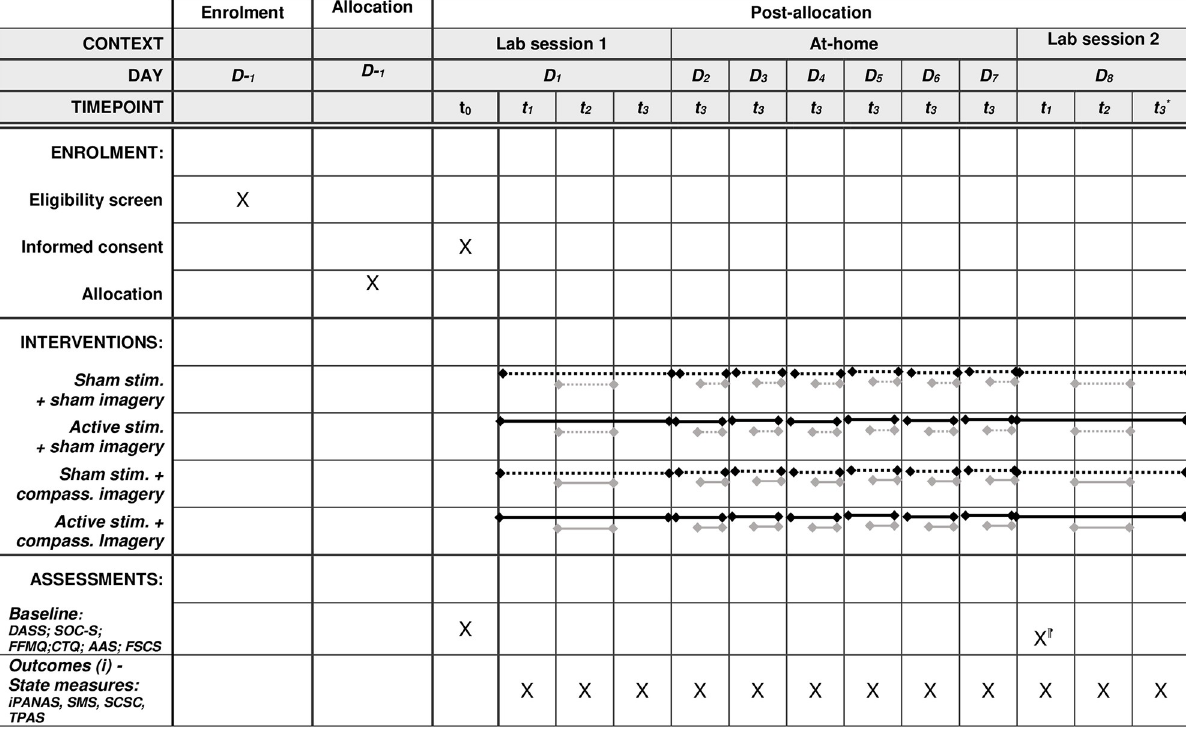
PLOS ONE | https://doi.org/10.1371/journal.pone.0282861 March 13,